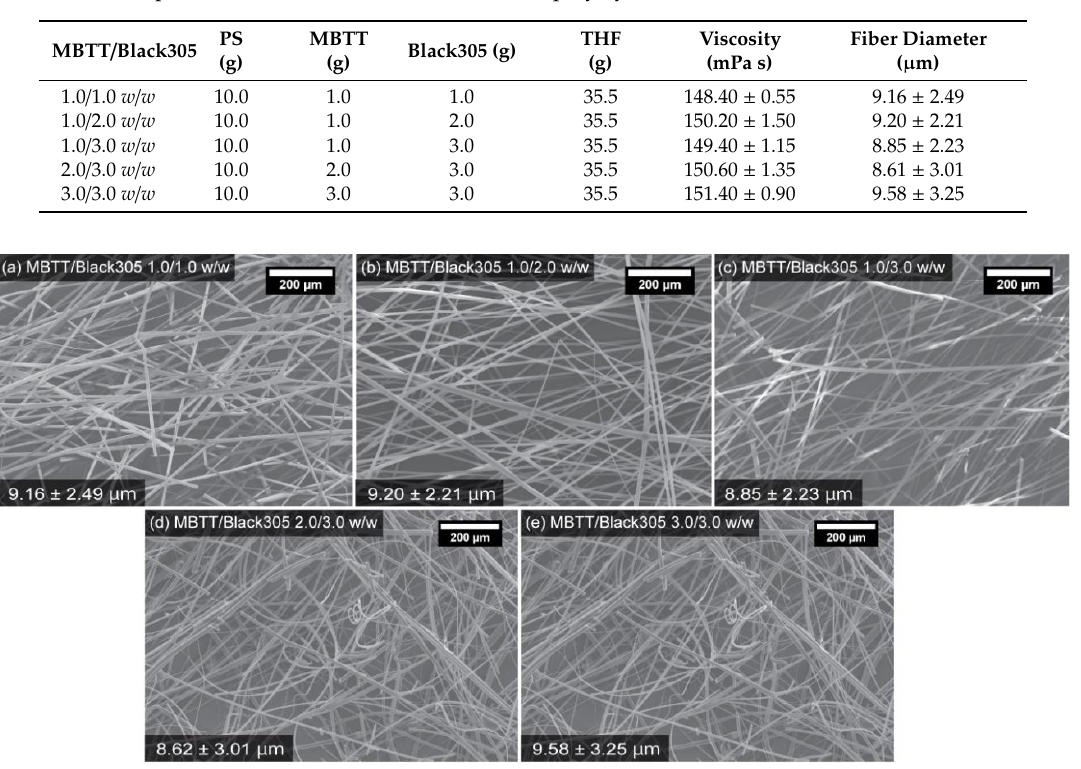
Table 1. Experimental conditions, viscosities of the polystyrene (PS) solutions, and fiber diameters.